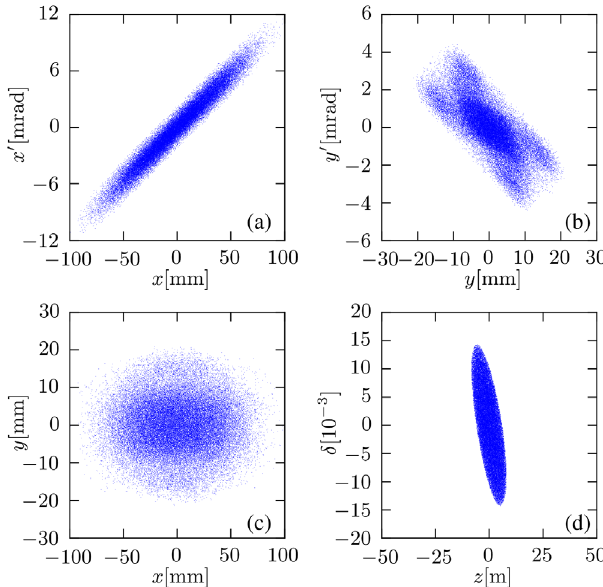
FIG. 8. Particle distribution in (a) x − x 0 phase space; (b) y − y 0 phase space; (c) x − y space; and (d) longitudinal z − δ phase space at turn 72 during bunch compression, with doubled bunch intensity.